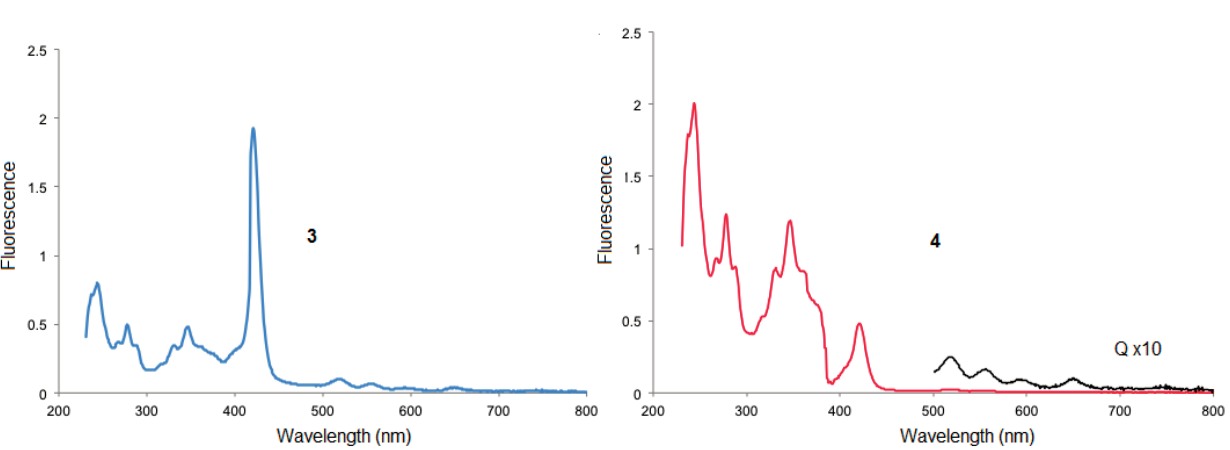
Figure 2. Absorption spectra of dendrimers 3 and 4 in CH 2 Cl 2 at room temperature at the concentration of 3.0 × 10 − 6